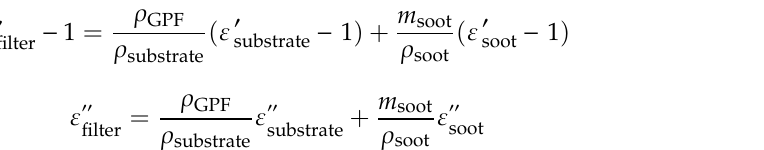
almost constant dielectric parameters were measured over the entire temperature range ( ε (cid:48)(cid:48) = 0.0009). and ε substrate